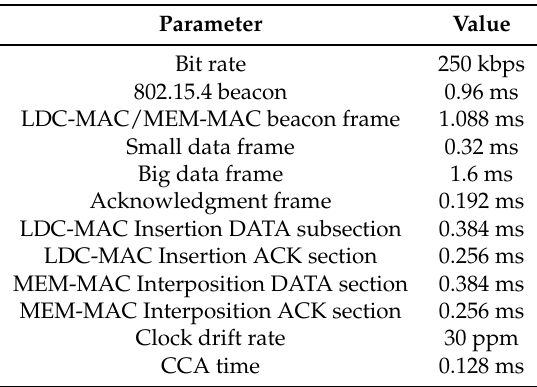
Table 2. Parameters related to MAC